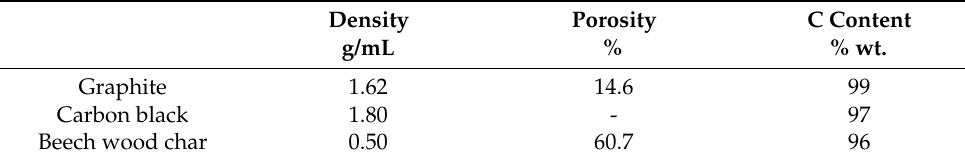
Table 1. Properties of materials.